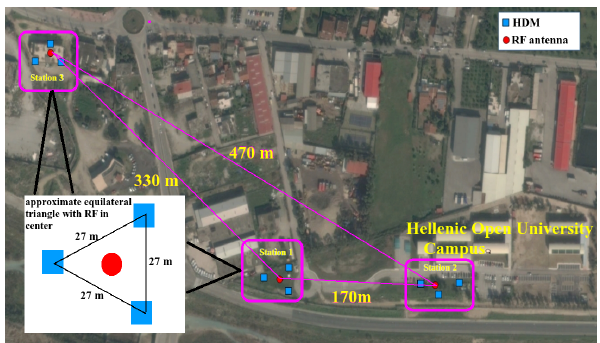
Figure 1. The outline of the ASTRONEU array installed at the HOU campus. Each of the three stations comprises three Hely- con Detector Modules and a CODALEMA type RF antenna. Pic- ture taken from [13].